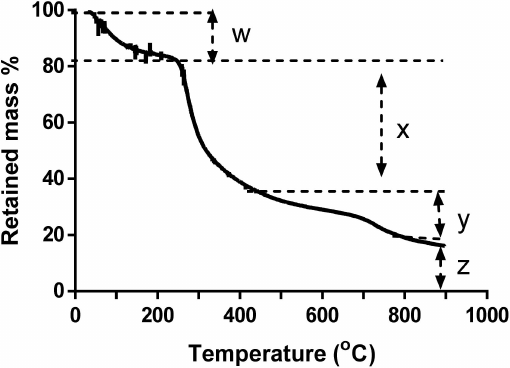
Figure 3. Thermogravimetric analysis ( TGA ) analysis of extracted E. radiata fucoidan. W—shows loss of readily volatile material (moisture content), X—represents polymer degradation, Y—combustion of carbon black and Z—ash